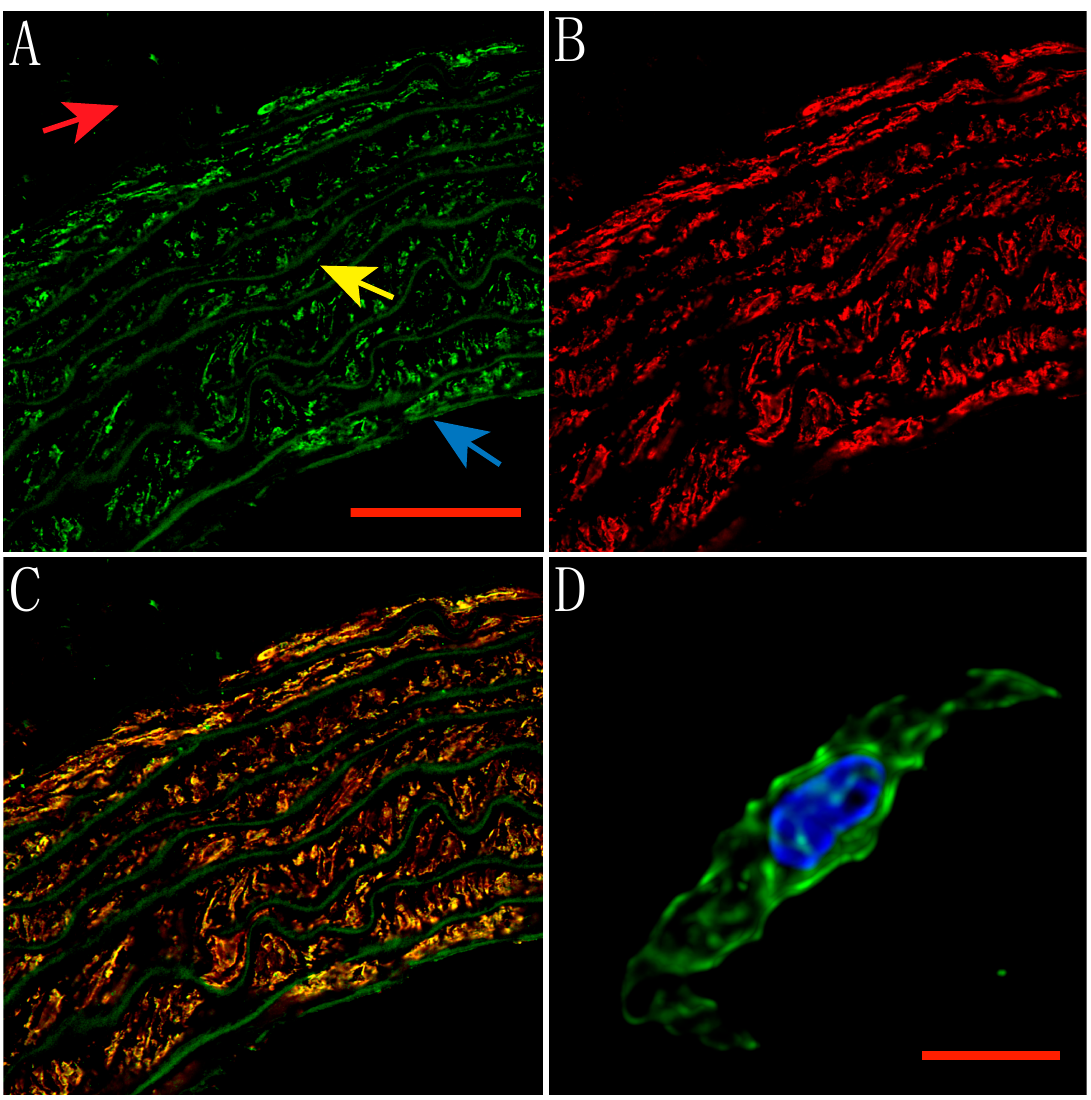
Figure 1. Expression of TRPV1 receptors in the smooth muscle of the rat aorta. ( A ) TRPV1 receptors labeled with FITC (Green). The scale bar corresponds to 50 μ m. ( B ) Aortic ring labeled with anti-smooth muscle α -actin conjugated with Alexa Fluor 568 (Red). ( C ) Overlay showing the high co-localization (Yellow) of TRPV1 receptors in smooth muscle. The arrows indicate the arterial layers. The adventitia is marked with red, the tunica media with yellow and the tunica intima with blue. ( D ) Aortic smooth muscle cell labeled with anti-TRPV1 (Green) and stained with DAPI (Blue). The scale bar corresponds to 10 μ m.